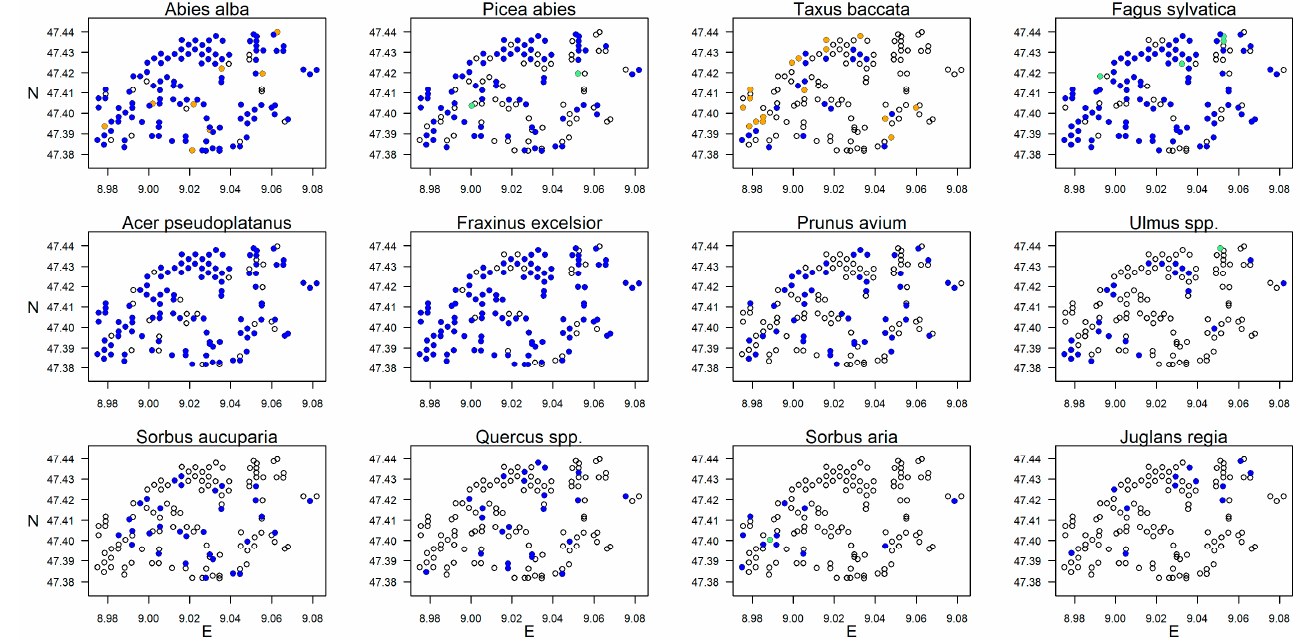
Figure 2. Spatial distribution (longitude and latitude) of the tree species found in >10 plots in the Kirchberg forest district. Open black circles represent plots without saplings, blue filled circles represent plots with saplings in HC1 to HC4 (for which the proportion of stocked area was calculated), green filled circles represent plots with no HC1 to HC4 saplings but with an HC5 sapling, and orange filled circles represent plots with no HC1 to HC4 saplings but with an HC0 sapling (only possible for Abies alba and Taxus baccata ).